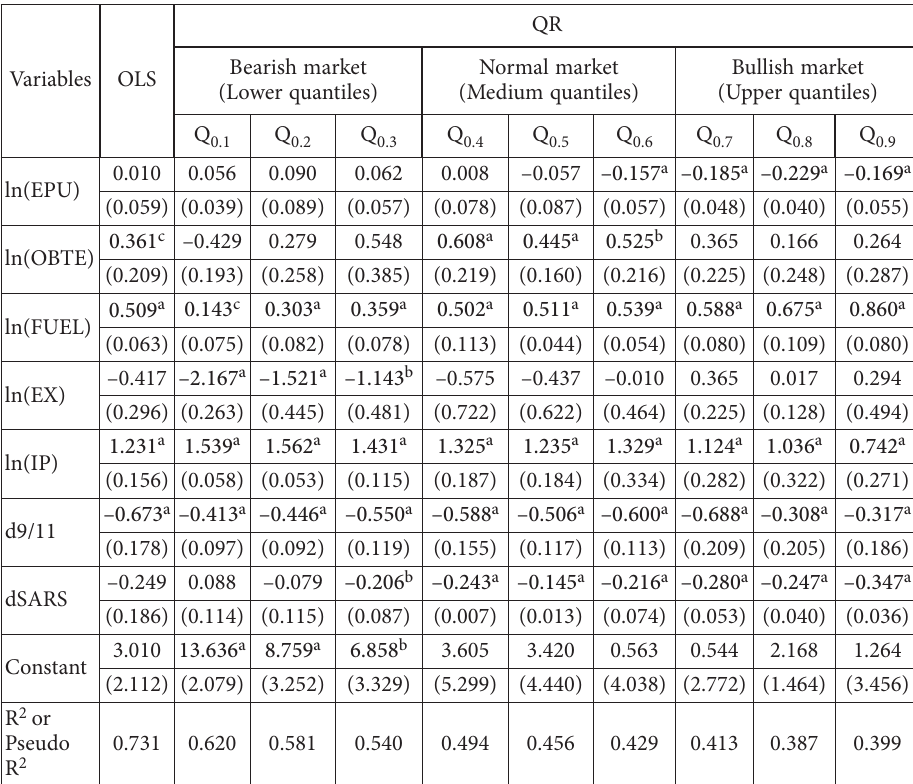
Table 2. Model 3 results for OLS and QR: Influence on the ASI Va riables OLS